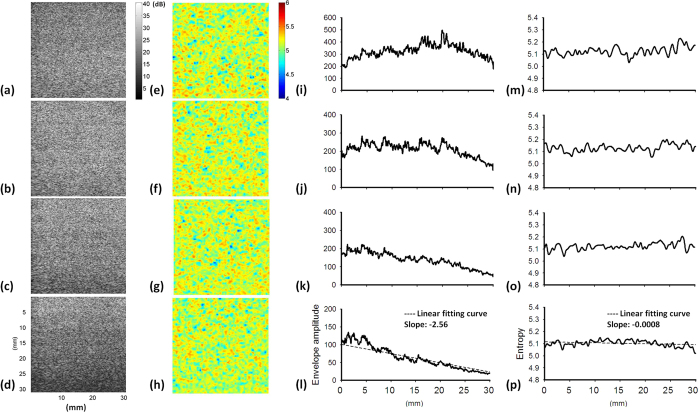
(a–d) B-mode images of Type-C agar phantoms to which lipid emulsions of 0%, 5%, 10%, and 20% were added (SL = 1; frequency = 6 MHz; scanned at a focus of 1 cm). The dimensions for all images are the same. The grayscale and color bars represent the pixel values (the brightness) of the B-mode and entropy images, respectively. (e–h) Entropy images corresponding to (a–d). (i) Entropy as a function of lipid concentration.